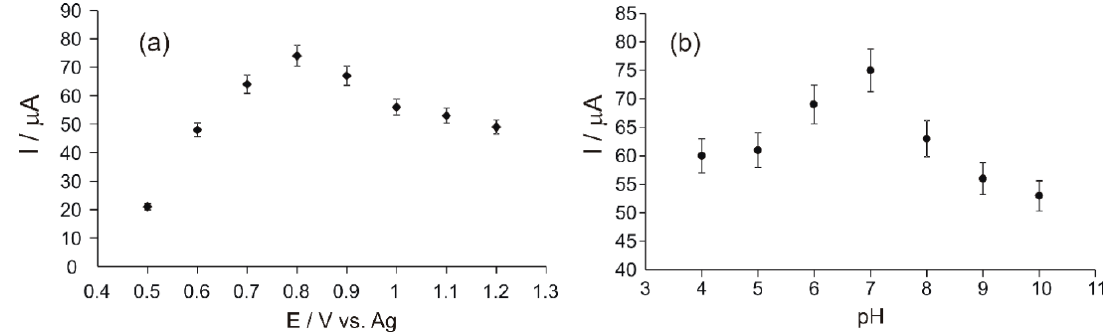
Figure 5. Effects of applied potential ( a ) and pH ( b ), respectively, on the response of Ty/PtNP/GPH/Chit -CSPE biosensor.